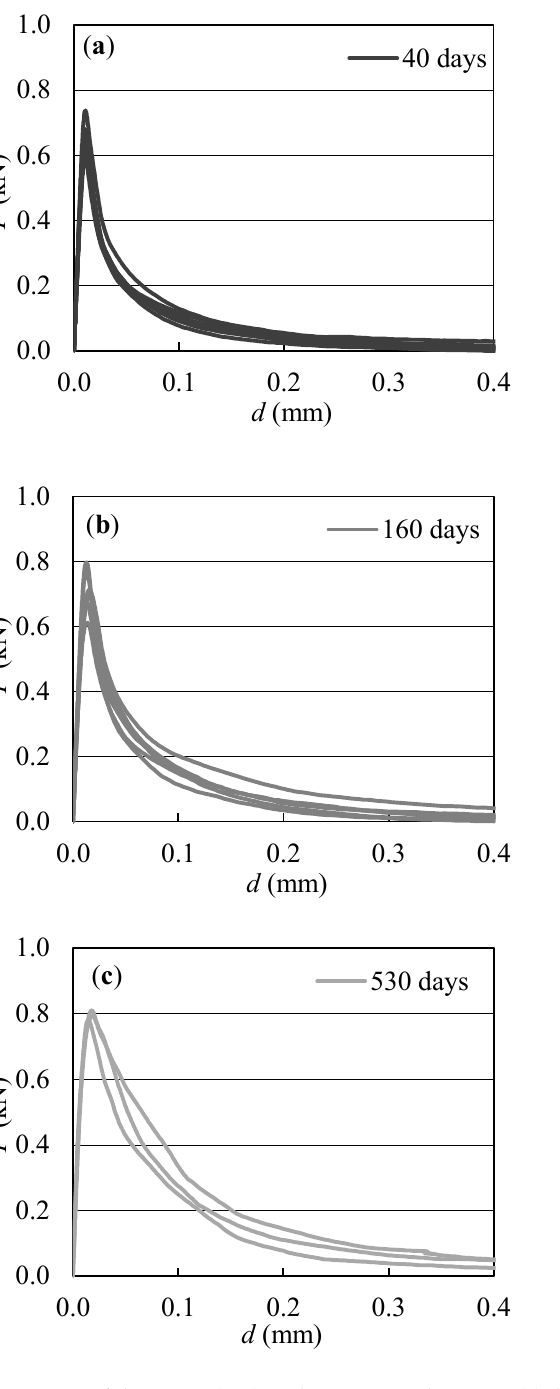
Figure 5. F − d diagrams ( a – c ) and F − CMOD diagrams ( d – f ) from 3PB fracture test for investigated ages of specimens: 40, 160 and 530 days,